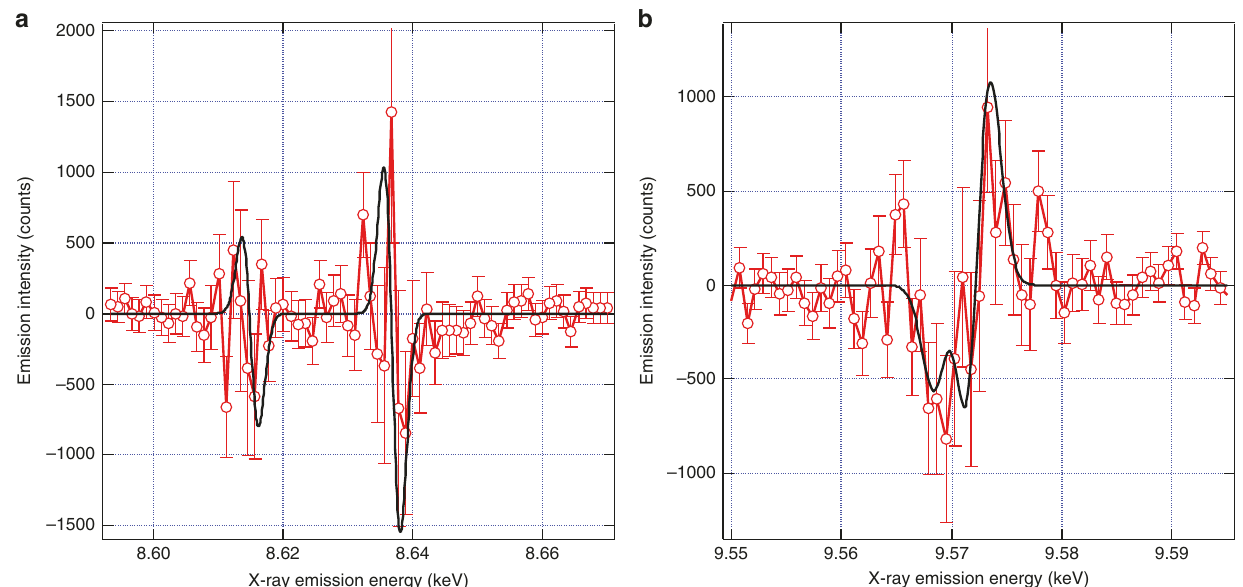
Fig. 5 XES transients compared to simulation. Transient XES signals measured at an incident energy of 9.8 keV corrected for the change in total X-ray absorption cross-section (see Supplementary Note 3 for details) for the Zn K α ( a ) and K β ( b ) emission signals (red data points) overlaid with the simulation of the transient XES signals using the excited state structure of the V 2 þ experimental